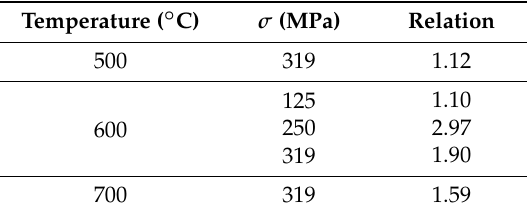
Comparison of the final creep time ( tf ) for the untreated condition in relation to